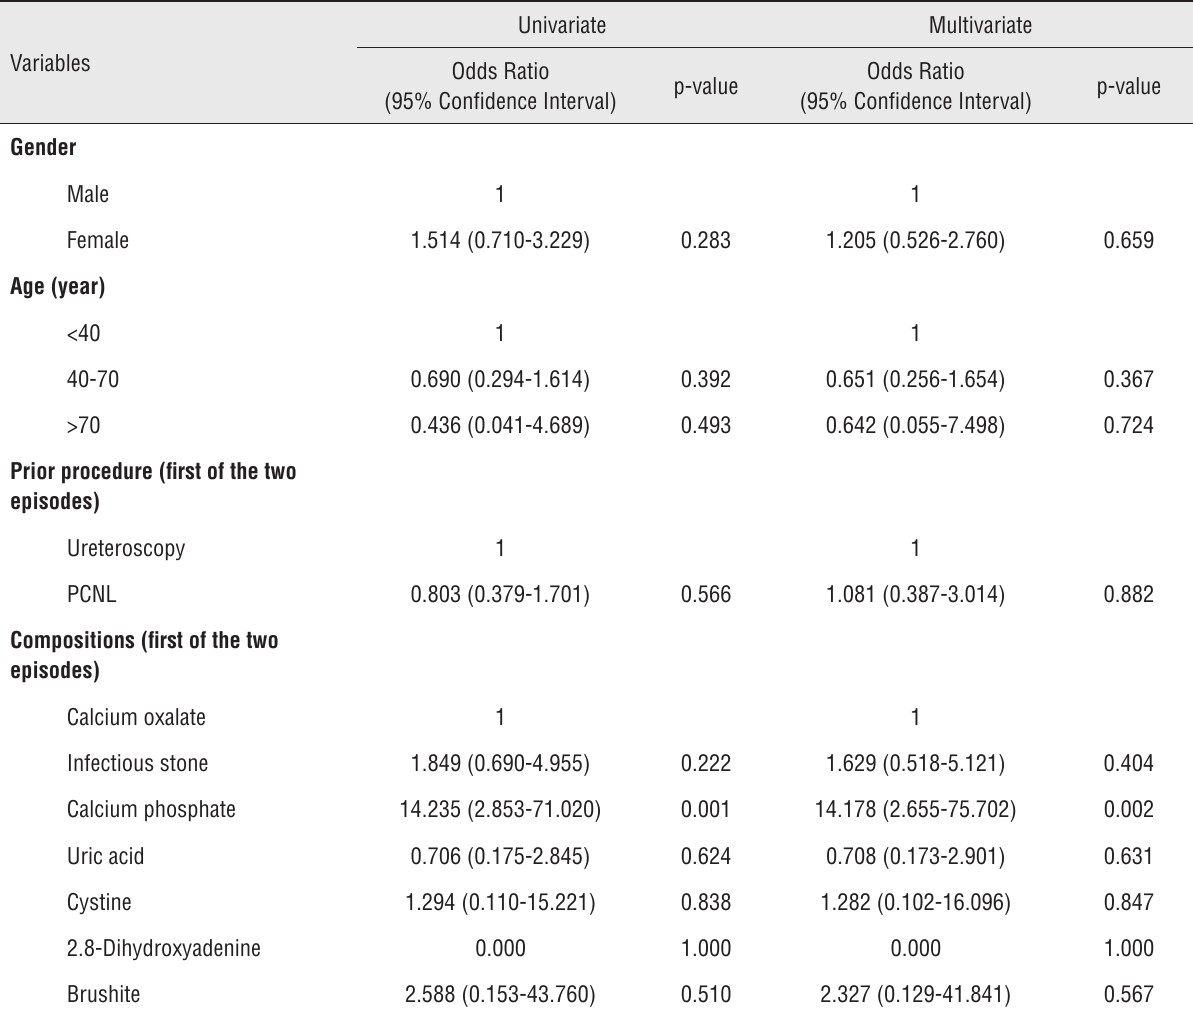
Supplementary Table 2 - Multivariate analysis of the predictors for stone composition